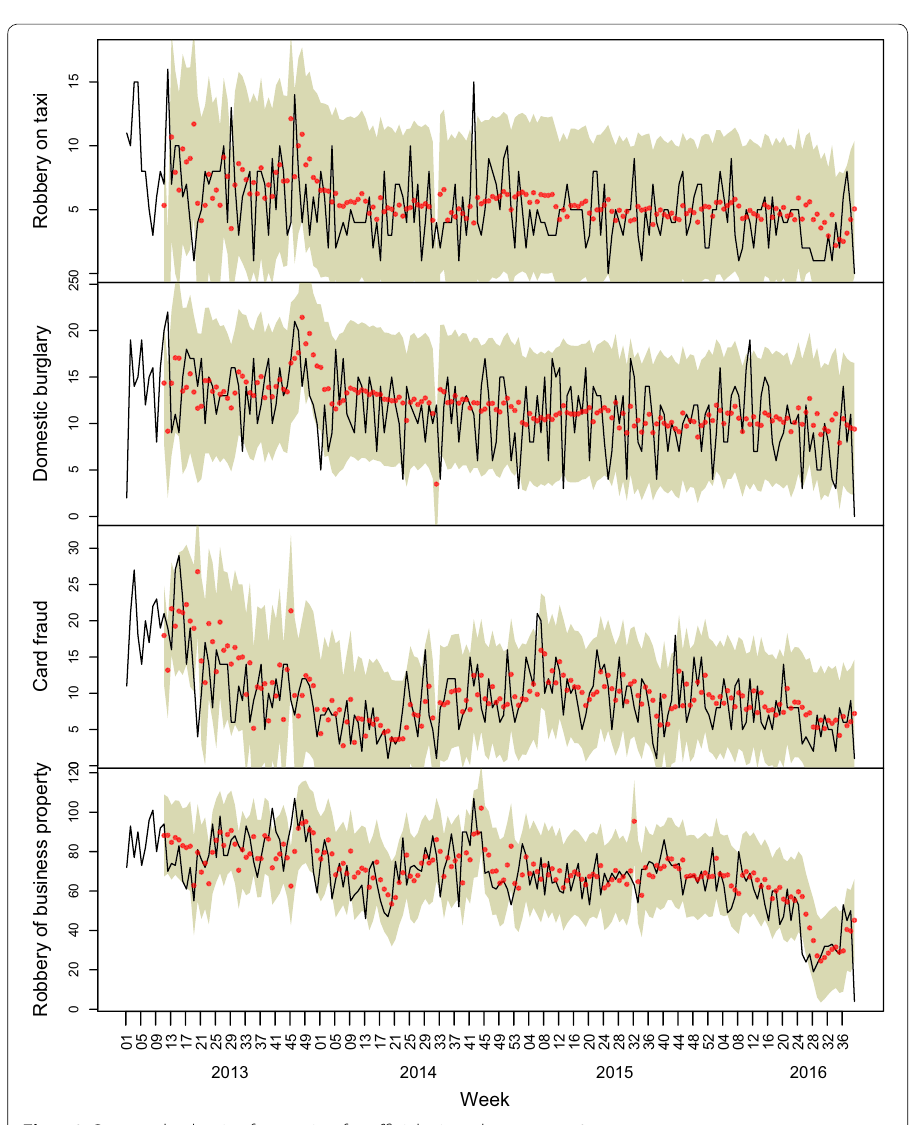
Fig. 16 One week adaptive forecasting for official crime dataset: part